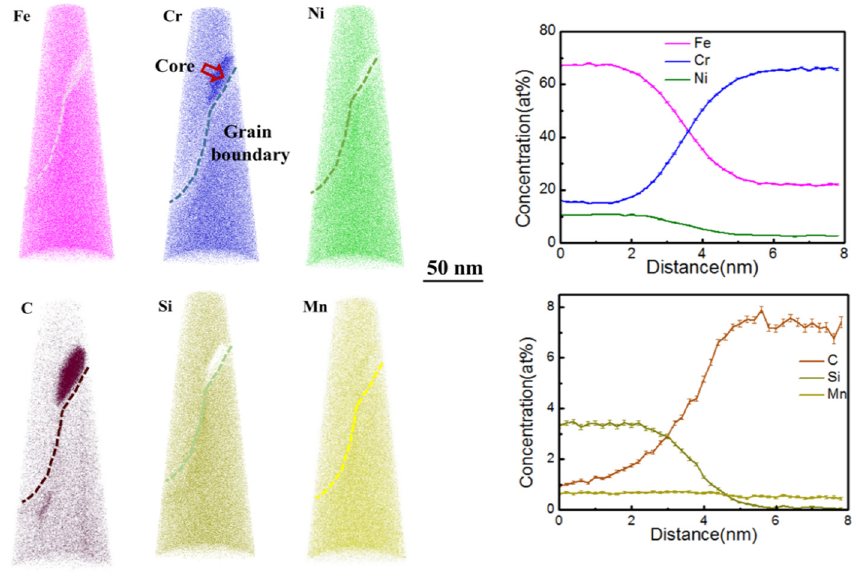
Figure 11. EDS of grain boundary of the creep sample in HAZ.